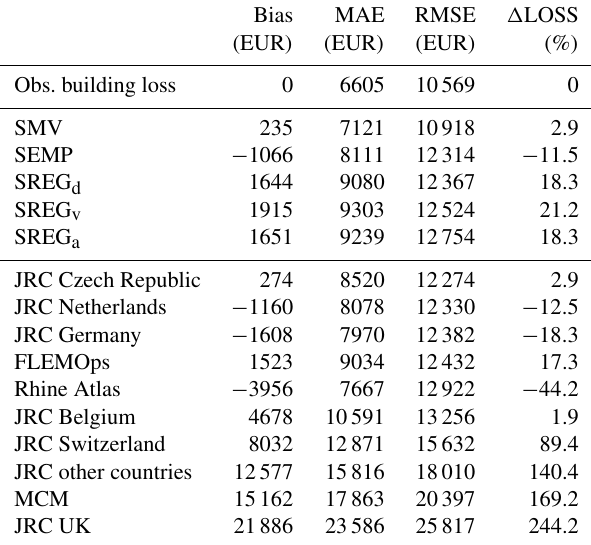
Table 8. Performance of different uni- and multivariable models in estimating relative damages and overall monetary loss to contents (see Eqs. 4, 5, 6 and 7; the observed overall monetary loss is equal to EUR10.4million). The first row shows the performance of Eq. (8) applied to the observed monetary damages to buildings; the first block represents the results of the application of Eq. (8) to monetary building damages estimated with locally derived models, while the second represents those estimated with literature models. Models in each group are ranked according to RMSE values, from the lowest to the largest.